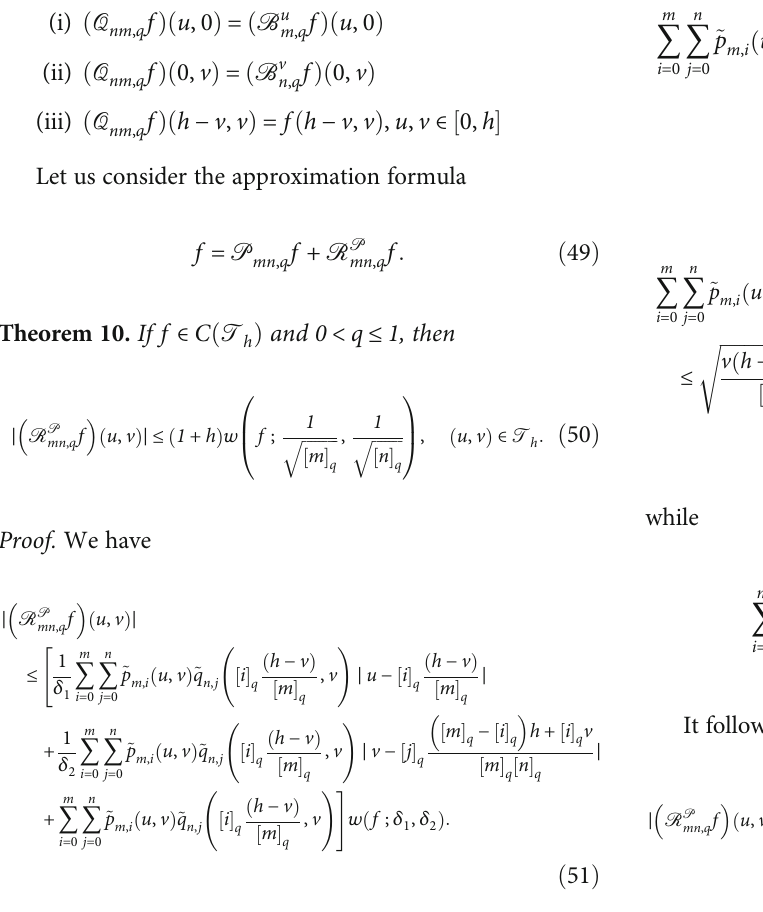
ffiffiffiffiffiffiffiffiffiffiffiffiffiffiffiffiffiffiffiffiffiffiffi u h − u − v ð